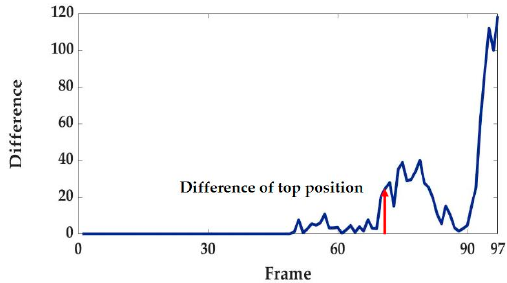
Figure 11. Fall detection feature applied to detect the recovery state.